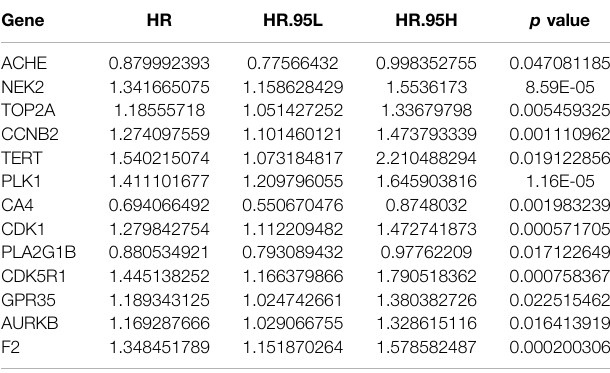
TABLE 3 | Univariate Cox regression analysis showed the prognostic factors of LUAD patients.